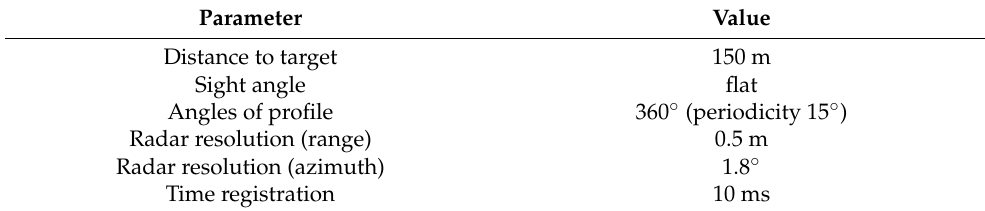
Table 1. Research conditions.